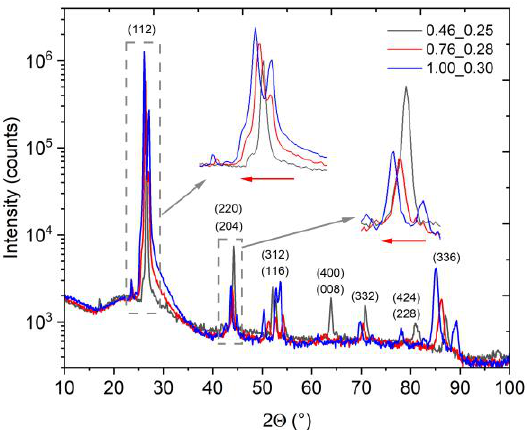
Figure 6. XRD spectra for three samples of ACIGSe with different AAC and similar GGI ratio, as indicated in the legend. For the main peaks, zoom-in pictures are given following the grey arrows; the red arrows indicate the shift of the main peak with increasing Ag content.